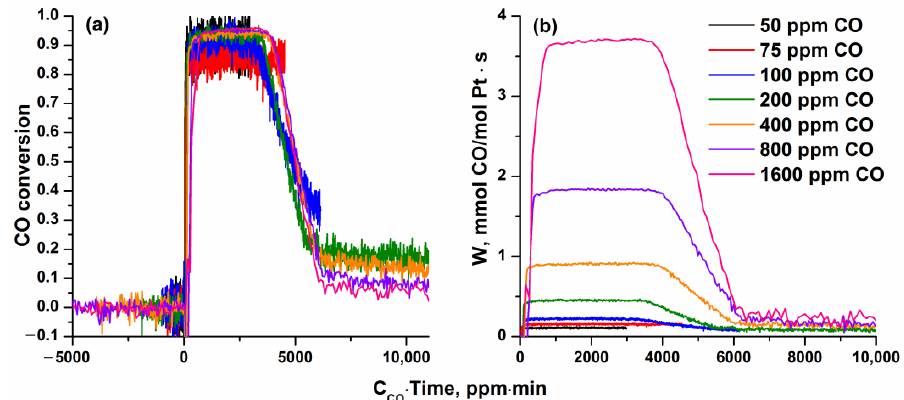
Figure 5. Dependencies of ( a ) CO conversion and ( b ) CO oxidation rate on CO exposure at 25 °C. The reaction mixture contains 50, 75, 100, 200, 400, 800, and 1600 ppm CO, 5 vol.% O 2 , 0.5 vol.% Ne, and He balance. The reaction mixture rate was 100 cm 3 /min. SV = 60 L/g·h.